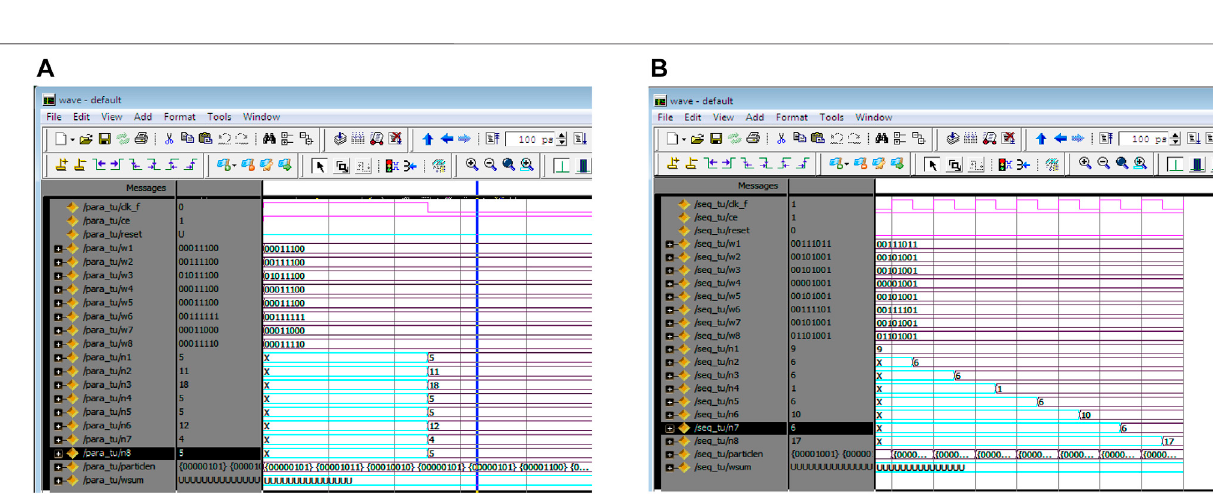
Frontiers in Energy Research |